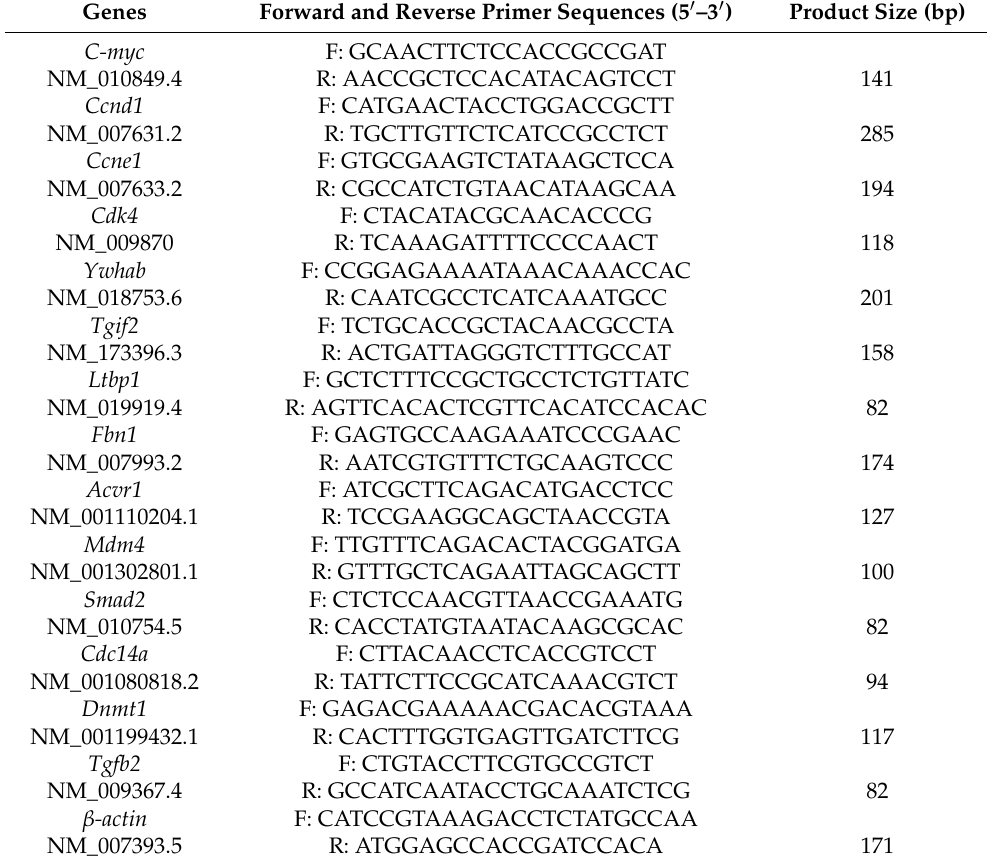
Table 1. Primer sequences for the quantitative reverse transcription polymerase chain reaction (RT-qPCR). Genes Forward and Reverse Primer Sequences (5 (cid:48) –3 (cid:48)